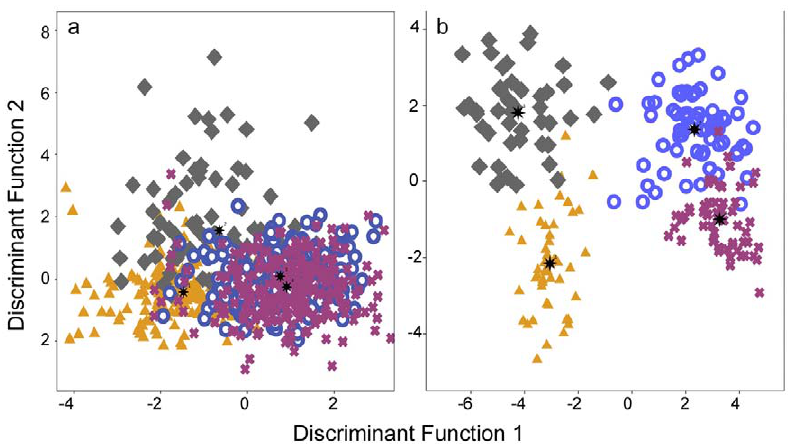
Figure 2. Vocal individuality shown by the overlap in discriminate scores of calls from four common vampire bats from either a single captive colony (a) or four different wild colonies (b). Plot shows the discriminant scores for the first two canonical discriminant functions constructed separately for each population. The four bats in each plot are denoted by different symbols.